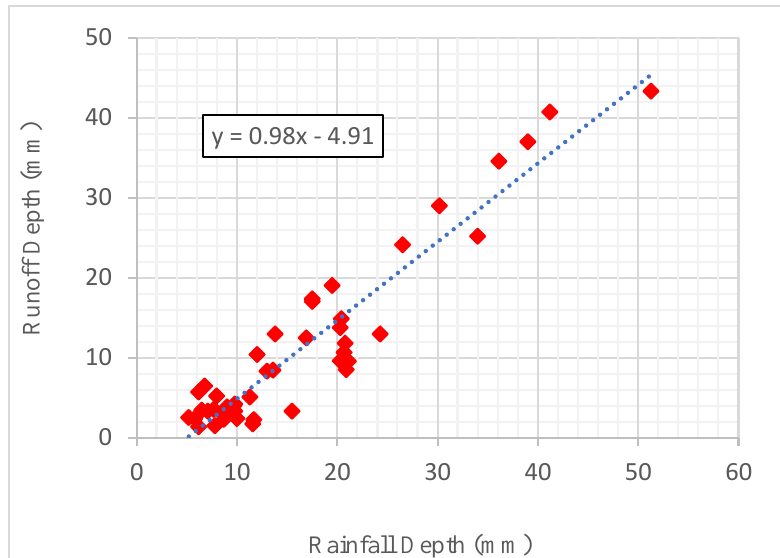
Figure 3. Mass balance of rainfall and runoff volumes for storms.